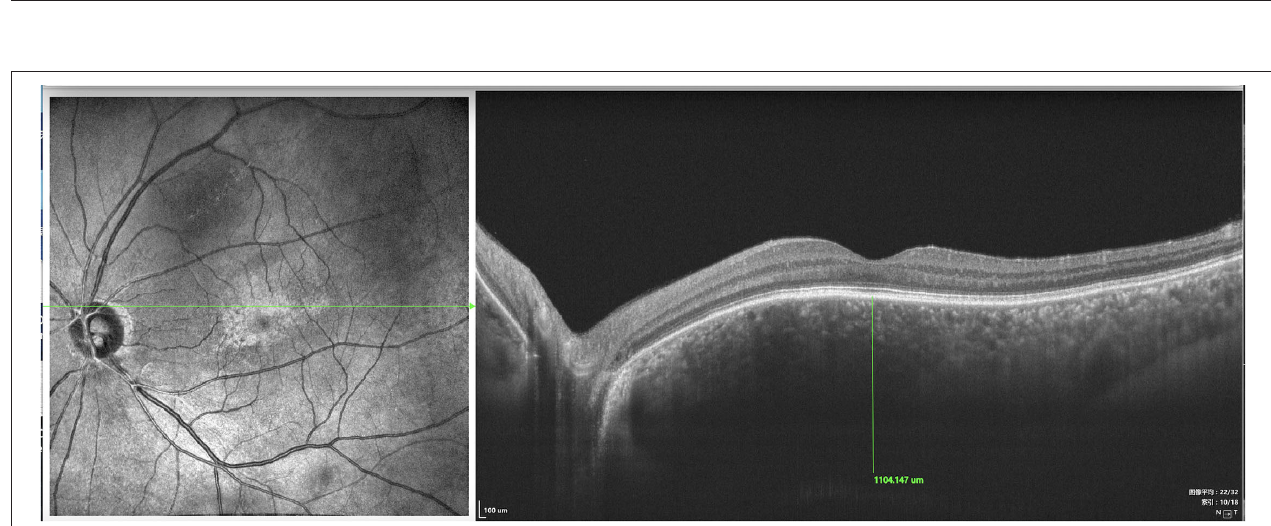
FIGURE 9 | SS-OCT (SS-OCT, VG200D, SVision Imaging, Ltd., China) in type 2 showed that each retinal layer was even with the pachychoroid, leopard-sign spots in the fundus corresponding to accumulation of outer retinal material, which presented as focal thickening of the RPE layer.